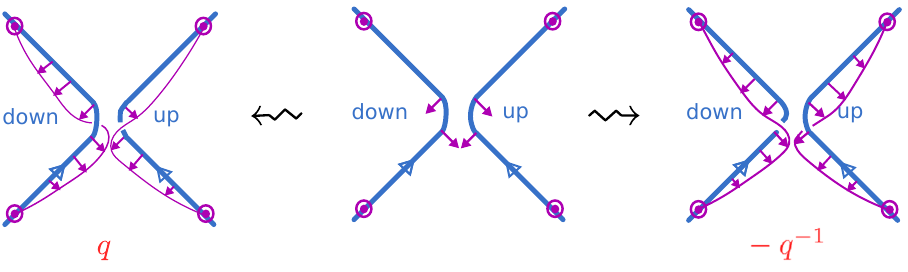
Figure 49 . The sum over two framings for a lifted exchange, with the original link in blackboard framing. Middle: the blackboard framing far from the exchange, and the framings f p near the exchange. Left: framing interpolated the \short way." This framing di(cid:11)ers from the blackboard framing by a factor of q . Right: framing interpolated the \long way." This framing di(cid:11)ers from the blackboard framing by a factor of q (cid:0) 1 . Summing over the two framings gives the factor q (cid:0) q (cid:0) 1